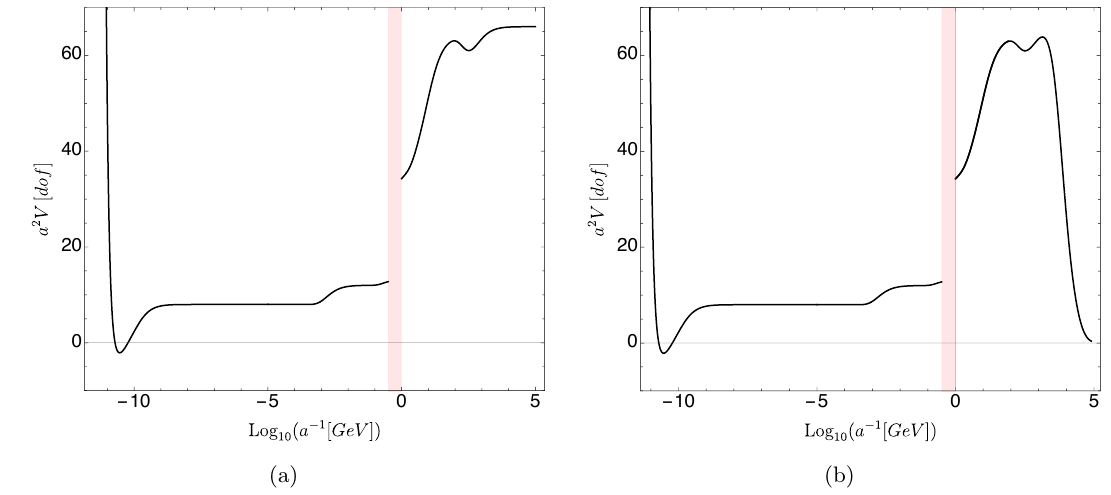
Figure 6 . (a) E(cid:11)ective potential of the MSSM compacti(cid:12)ed in T 2 =Z 4 embedded into B (cid:0) L and the Higgs (cid:12)xed at its minimum. The only possible AdS minimum which may arise is the one associated with neutrino bounds. (b) E(cid:11)ective potential of the MSSM compacti(cid:12)ed in T 2 =Z 4 and embedded into U(1) s . The Higgs is (cid:12)xed at its minimum. The only possible minimum is the one associated with neutrino bounds. Recall that 2D minima only appear when V ( a ) crosses zero. The neutrino minimum may be avoided (in both cases) if the lightest Dirac neutrino is light enough.